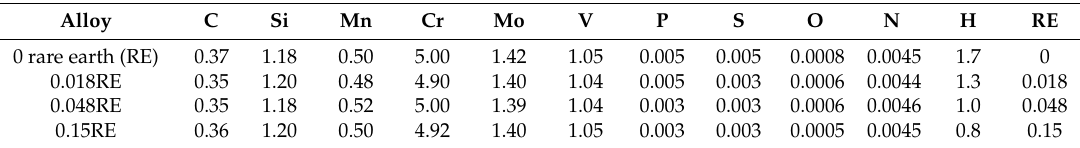
Table 1. Chemical composition of test steels (wt